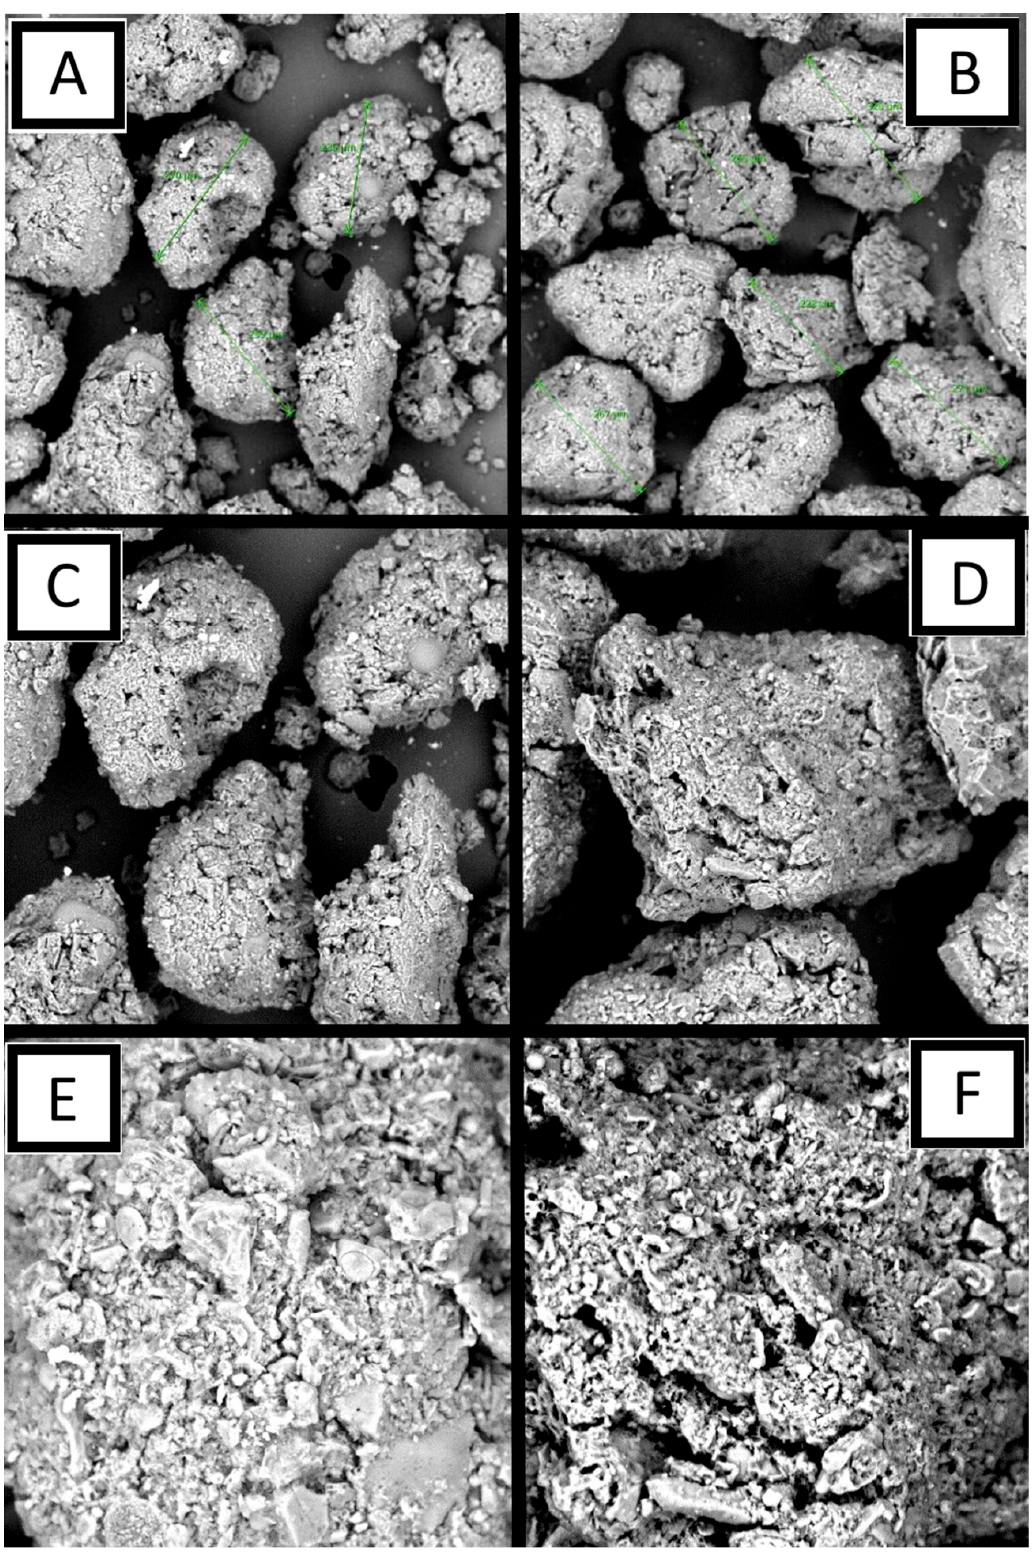
Figure 8. SEM pictures of the Australian lignite dried in a laboratory muffle furnace at 100 ◦ C ( A , C , E ) and torbed dryer at 50 ◦ C ( B , D , F )—magnifications × 300 ( A , B ), × 750 ( C , D ) and × 1500 ( E , F ); sample sieved through screen with aperture of 0.4